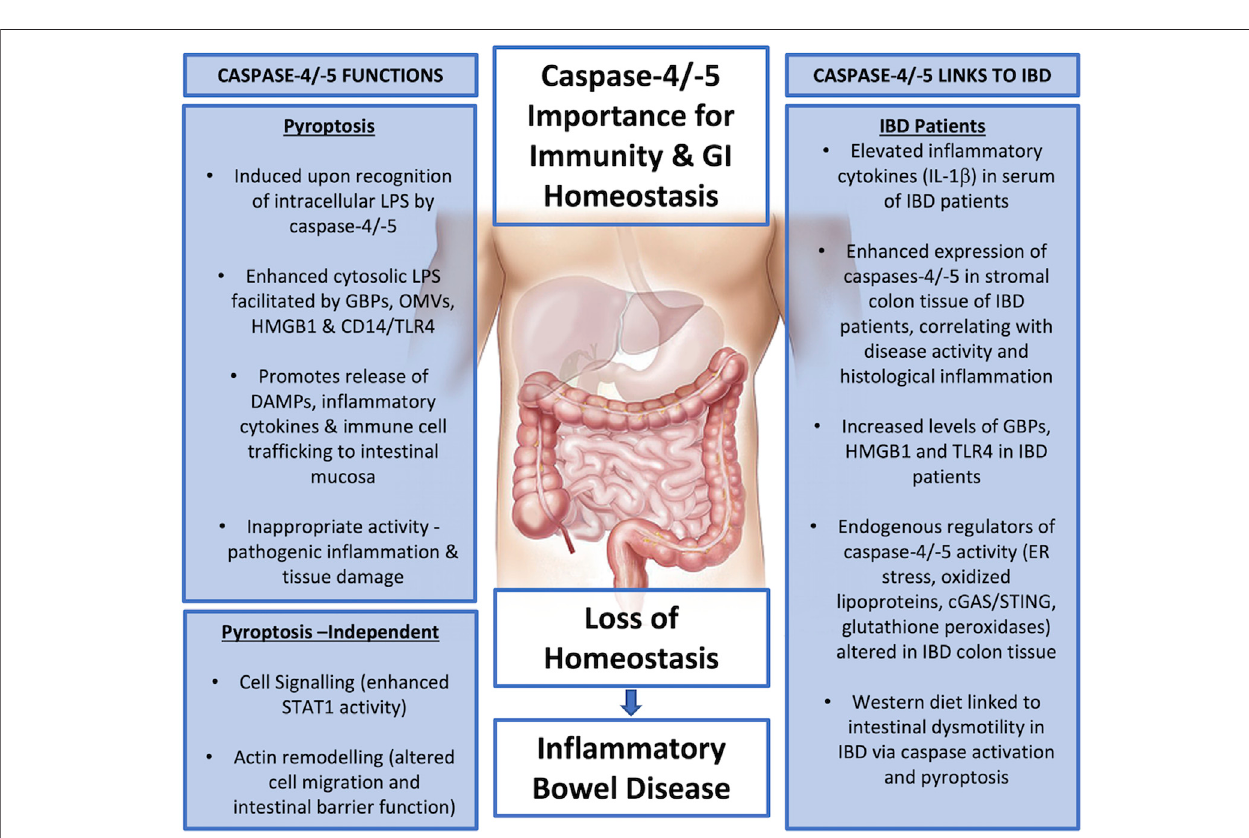
FIGURE 4 | Summary diagram - Caspase-4 and -5 functions and links to IBD